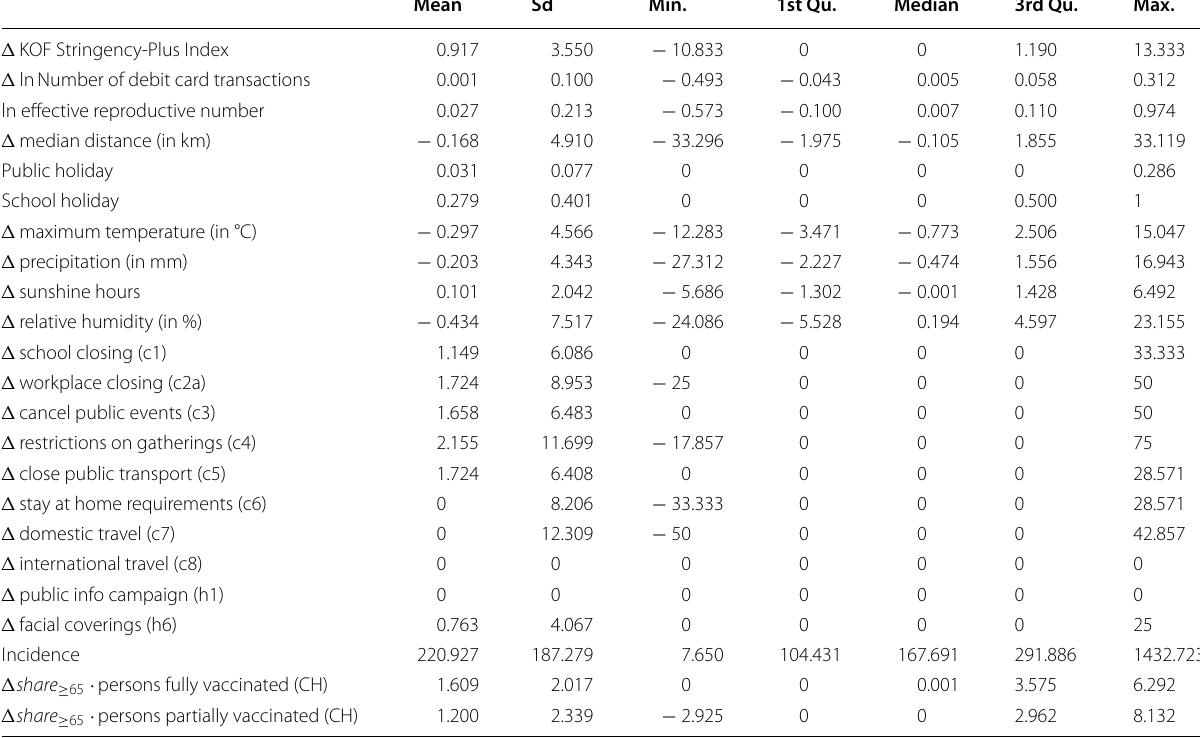
Table 1 Summary